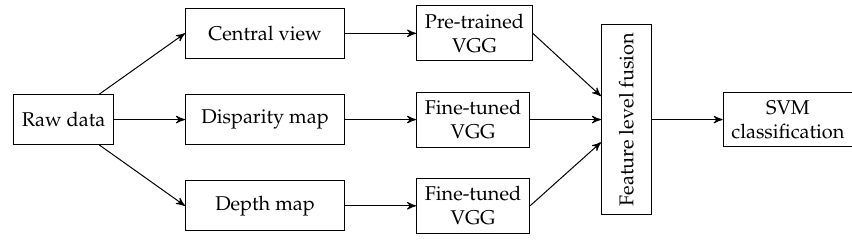
Figure 13. Workflow of the method proposed in [66].